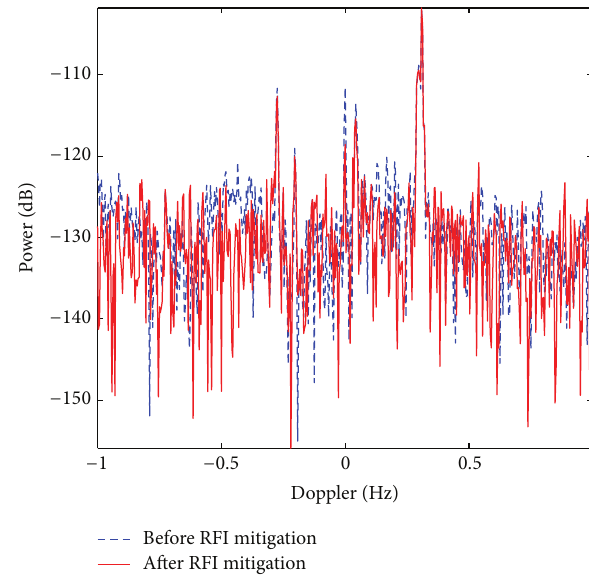
Figure 9: Range bin 8 cuts before and after RFI mitigation by the introduced method.